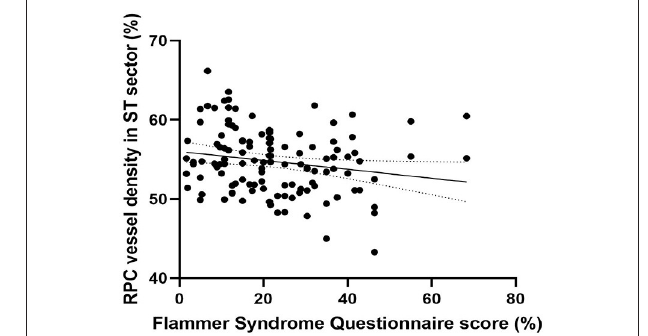
FIGURE 2 | Correlation matrix between peripapillary retinal nerve fiber layer thickness and RPC vessel density performed by spearman analysis ( r = 0.417, p < 0.001).